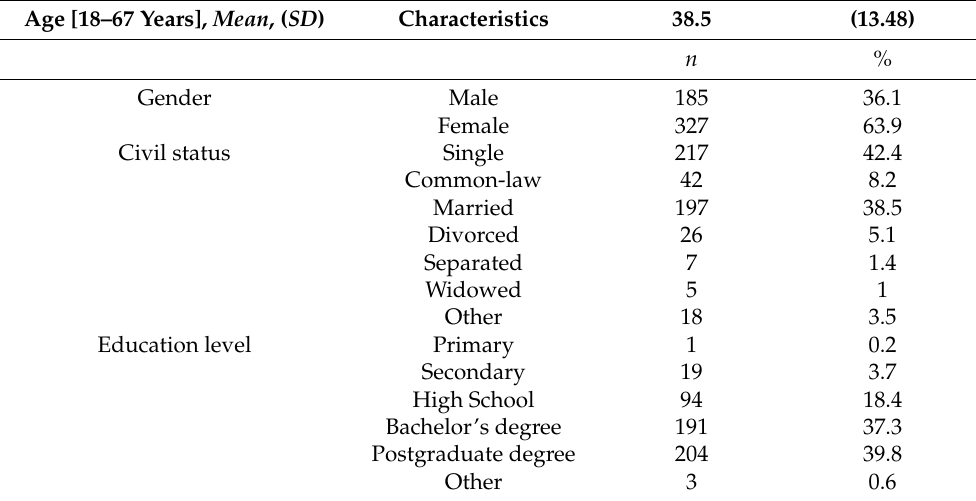
Table 3. Sociodemographic characteristics of the participants of the validity study ( n =